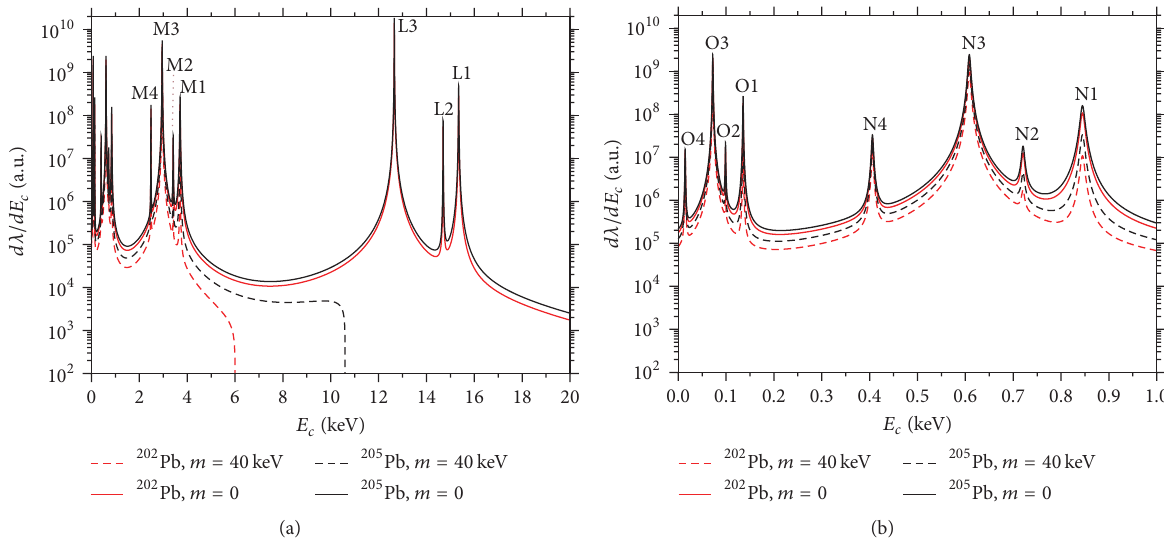
Figure 2: Calorimeter spectrum after electron capture in 202 Pb (light curves) and in 205 Pb (black curves) with emission of a light neutrino, = 0 (solid curves) and a heavy neutrino, 𝑚 = 40 keV (dashed curves). (a) Full spectrum, showing L and M capture peak labels. (b) Low 𝑚 𝑙 ℎ energy region ( 𝐸 𝑐 = 0 - 1 keV), showing N and O capture peak